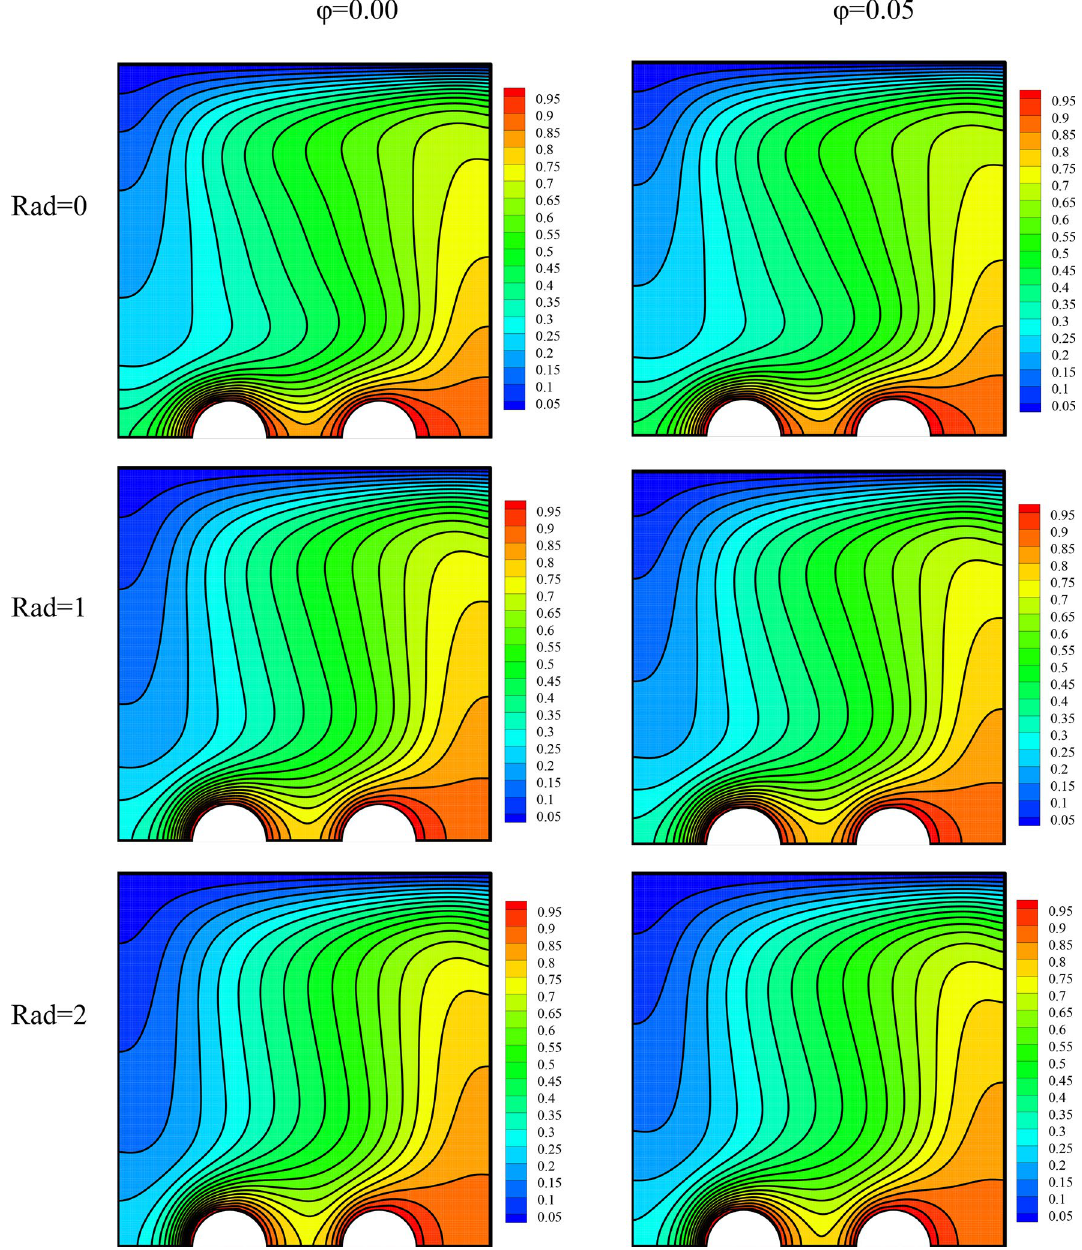
Figure 5. The temperature field for a variable radiation parameter and different volume fractions at λ = 0°, Ra = 10 5 , γ = 45°, Ha =